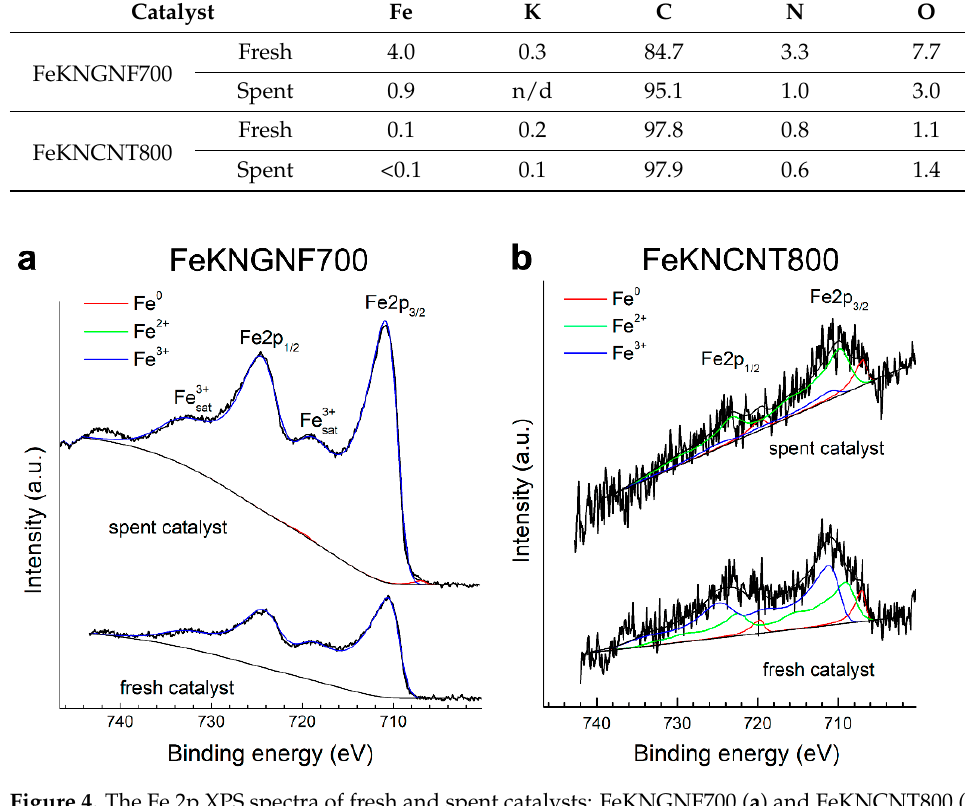
Figure 4. The Fe 2p XPS spectra of fresh and spent catalysts: FeKNGNF700 ( a ) and FeKNCNT800 ( b